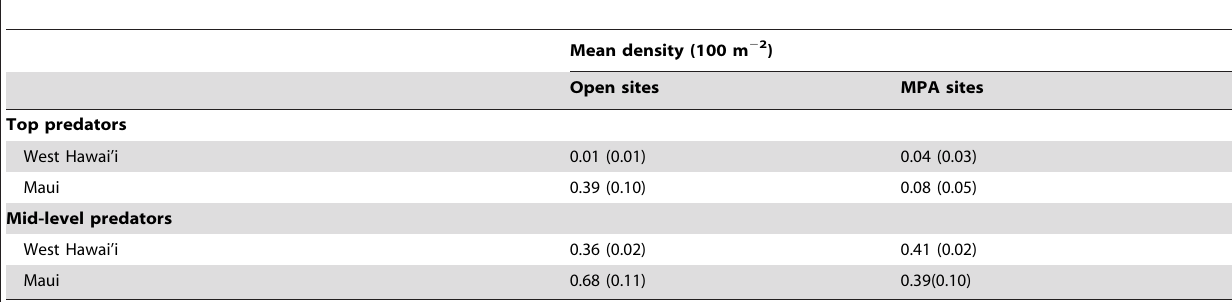
Table 3. The mean density ( 6 1 SE) of top and mid-level predators on Maui and West Hawai’i under different management regimes.